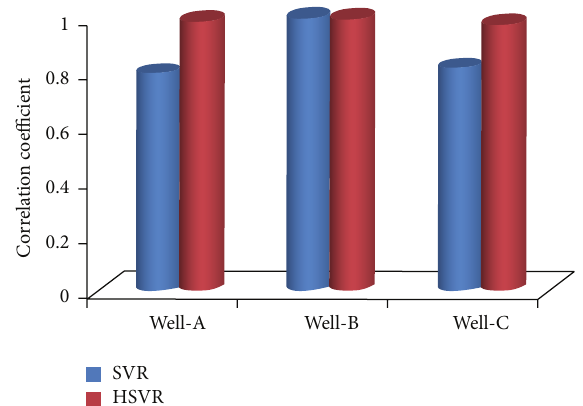
Figure 11: Correlation coefficient for SVR and HSVR (testing